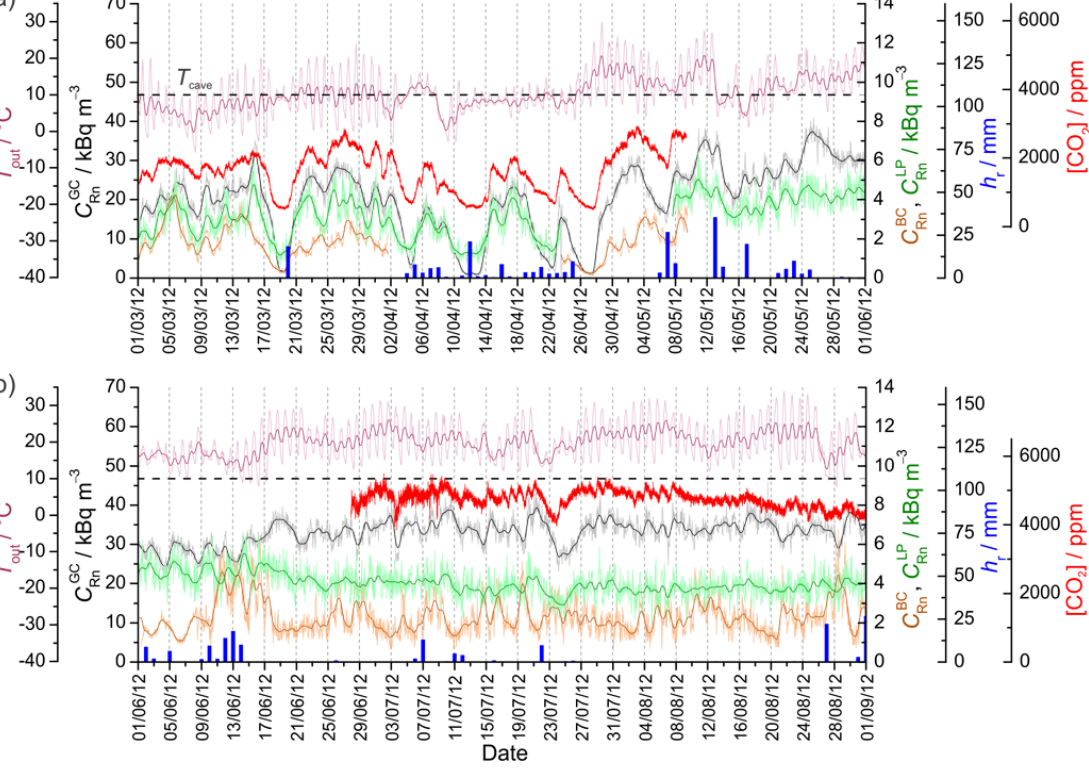
) , , Lepe jame – C BC and the lowest point – C LP Rn Rn Rn